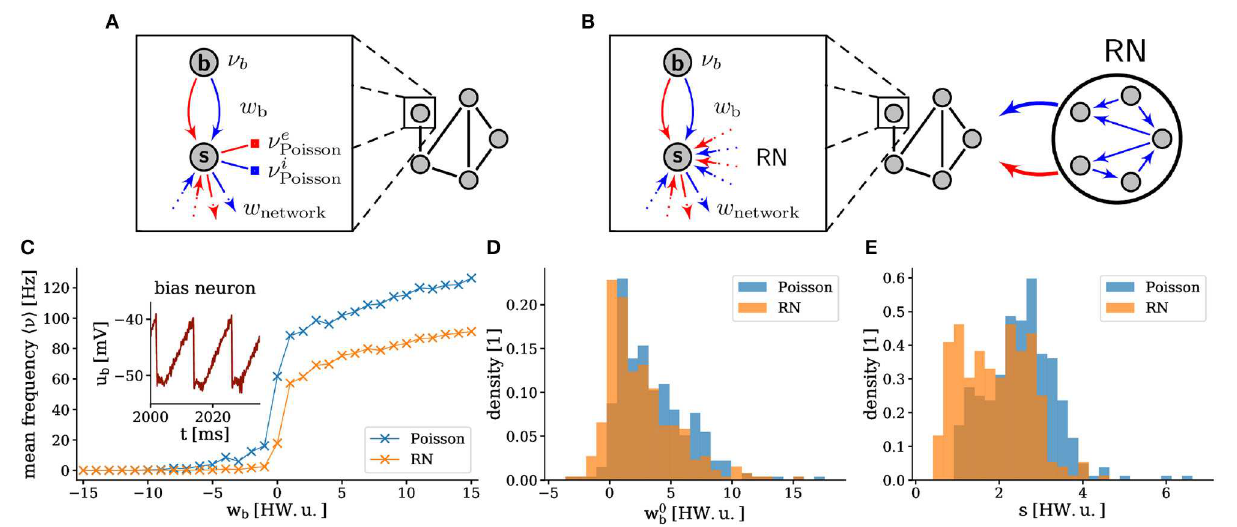
FIGURE 3 | Experimental setup. Each sampling unit is instantiated by a pair of neurons on the hardware. The bias neuron is configured with a suprathreshold leak potential and generates a regular spike train that impinges on the sampling neuron , thereby serving as a bias, controlled by w b . (A) As a benchmark, we provided each sampling neuron with private, off-substrate Poisson spike sources. (B) Alternatively, in order to reduce the I/O load, the noise was generated by a random network (RN). The RN consisted of randomly connected inhibitory neurons with E leak > V thresh . Connections were randomly assigned, such that each sampling neuron received a fixed number of excitatory and inhibitory pre-synaptic partners ( Table 1 ). (C) Exemplary activation function (mean firing frequency) of a single sampling neuron with Poisson noise and with an RN as a function of the bias weight. The standard deviation of the trial-to-trial variability is on the order of 0.1 Hz for both activation functions, hence the error bars are too small to be shown. The inset shows the membrane trace of the corresponding bias neuron. (D,E) The figures show histograms over all neurons in a sampling network on a calibrated BrainScaleS system. The width s and the midpoint w 0 b of the activation functions with Poisson noise and with an RN are calculated by fitting the logistic function h ν i = ν 0 / { 1 + exp[ − ( w b − w 0 b ) / s ] } to the